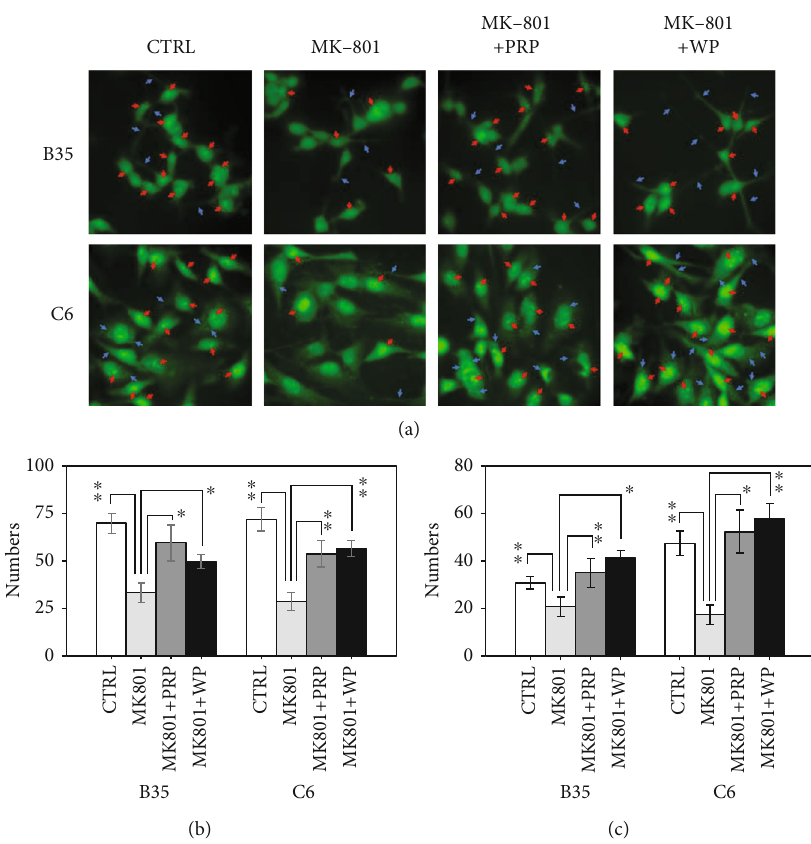
Figure 2: E ff ects of PRP and WP on actin fi lament reorganization in B35 and C6 cells treated with MK-801. MK-801-treated B35 and C6 cells on coverslips were incubated with PRP or WP accordingly. ActinGreen ™ 488 RreadyProbes ™ reagent was used for F-actin in staining in B35 and C6 cells. (a) Red arrows show actin nucleation and blue arrows show F-actin condensation. The numbers of (b) actin nucleation and (c) F-actin condensation were obtained by counting the condensed actin spot in nuclei or condensed actin fi lament in extended- cytoplasm in 100 cells under di ff erent fi elds of view. The bar charts were made from three independent batches of experiments and analyzed by using Student ’ s t -test ( ∗ p value < 0.05; ∗∗ p value < 0.01)